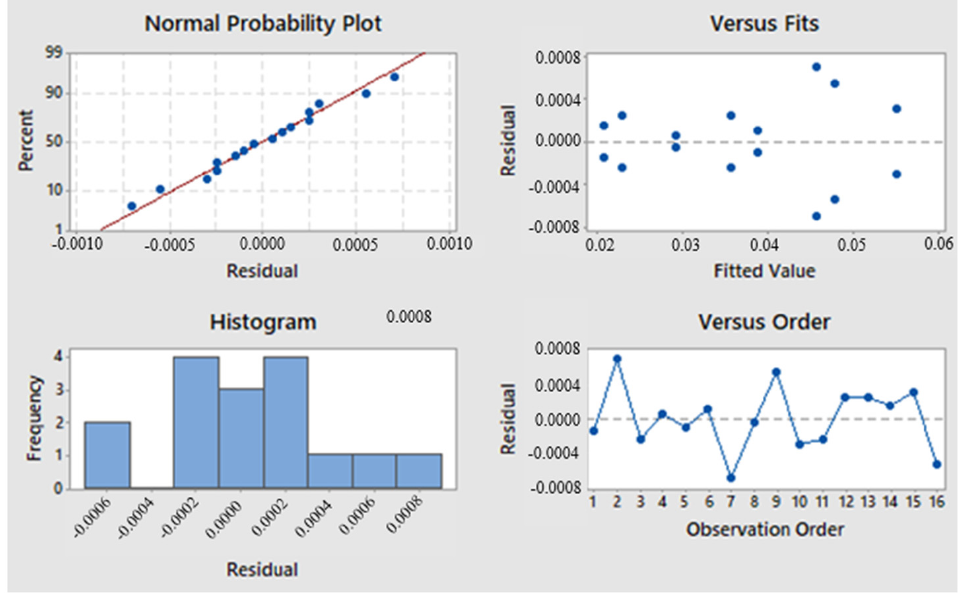
Figure 8. Residual plots for smoldering velocity.